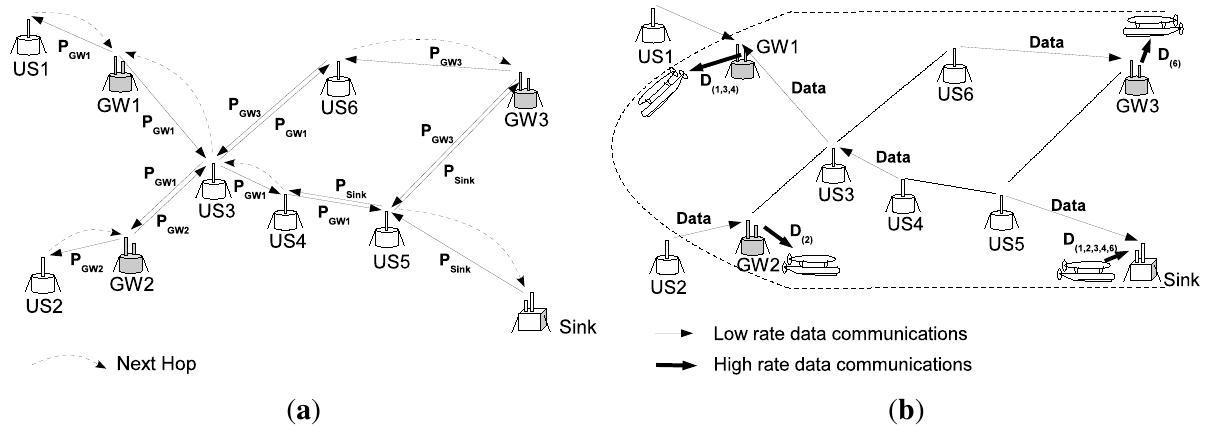
Figure 2. AUV-aided Underwater Routing Protocol: ( a ) Next hop determination based PHE Msg; ( b ) Data forwarding and